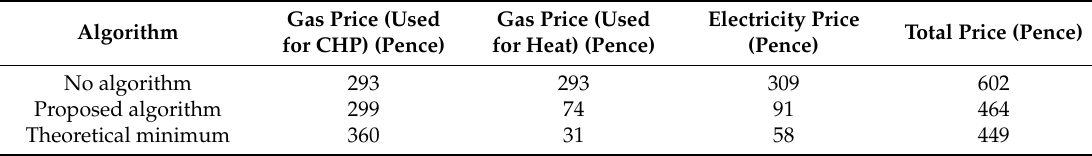
Table 1. Energy cost for in case study without algorithm, proposed algorithm and theoretical